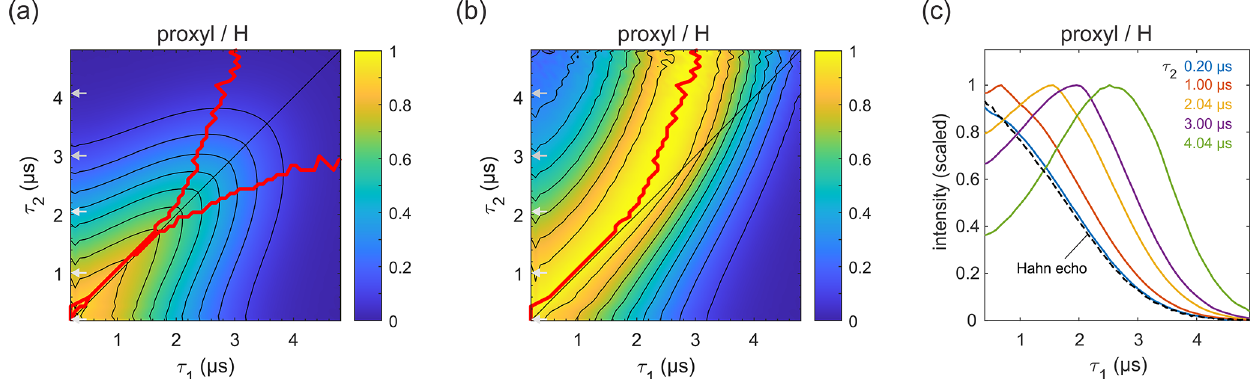
Figure 3. Refocused echo decay for 100µM 3-maleimido-proxyl in H 2 O / glycerol (80 : 20 v/v ) at 25K. Panel (a) shows the echo amplitude as a function of τ 1 and τ 2 , and panel (b) shows the same data after normalization of each slice along τ 1 . The red lines (a, b) indicate the location of the maxima along τ 1 for fixed τ 2 (upper line) and vice versa (lower line; only in a ). Panel (c) shows slices along τ 1 for several τ 2 values (indicated by grey arrows in a, b ), together with a Hahn echo decay.